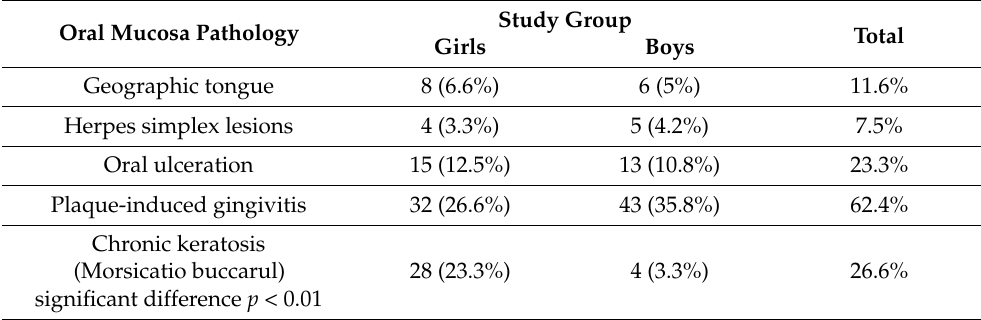
Table 3. Oral mucosa pathologies present in patients representing the study group.